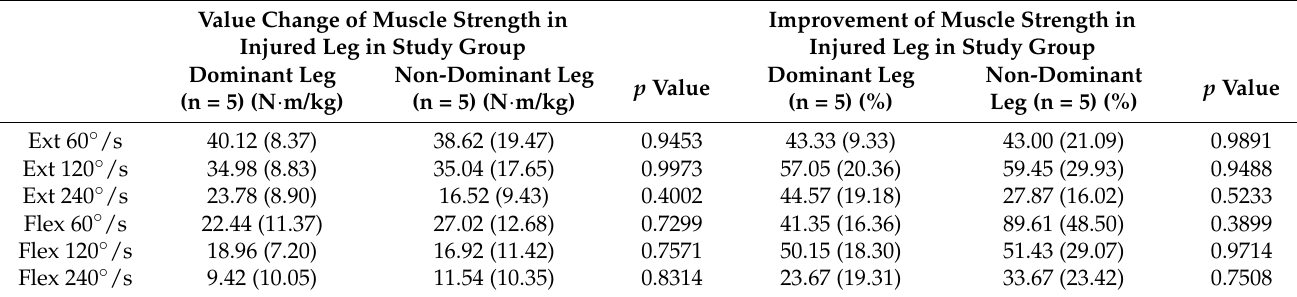
Table 5. Effects on the muscle strength change and improvement after training between the dominant and non-dominant PCL injured leg in the study